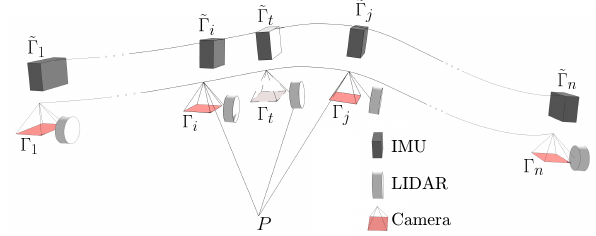
Figure 1. Description of the complete trajectory based on camera pose parameters only. No photos are taken at time t . Γ t is not a parameter but could be computed from Γ i and Γ j via interpolation of double